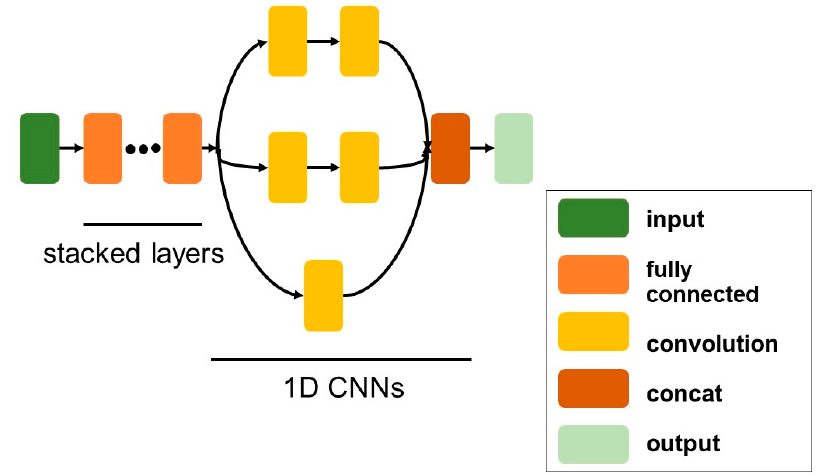
Figure 5. One-dimensional fully-connected layer first convolutional neural network (1D FCLF-CNN) constructed using the inception module.